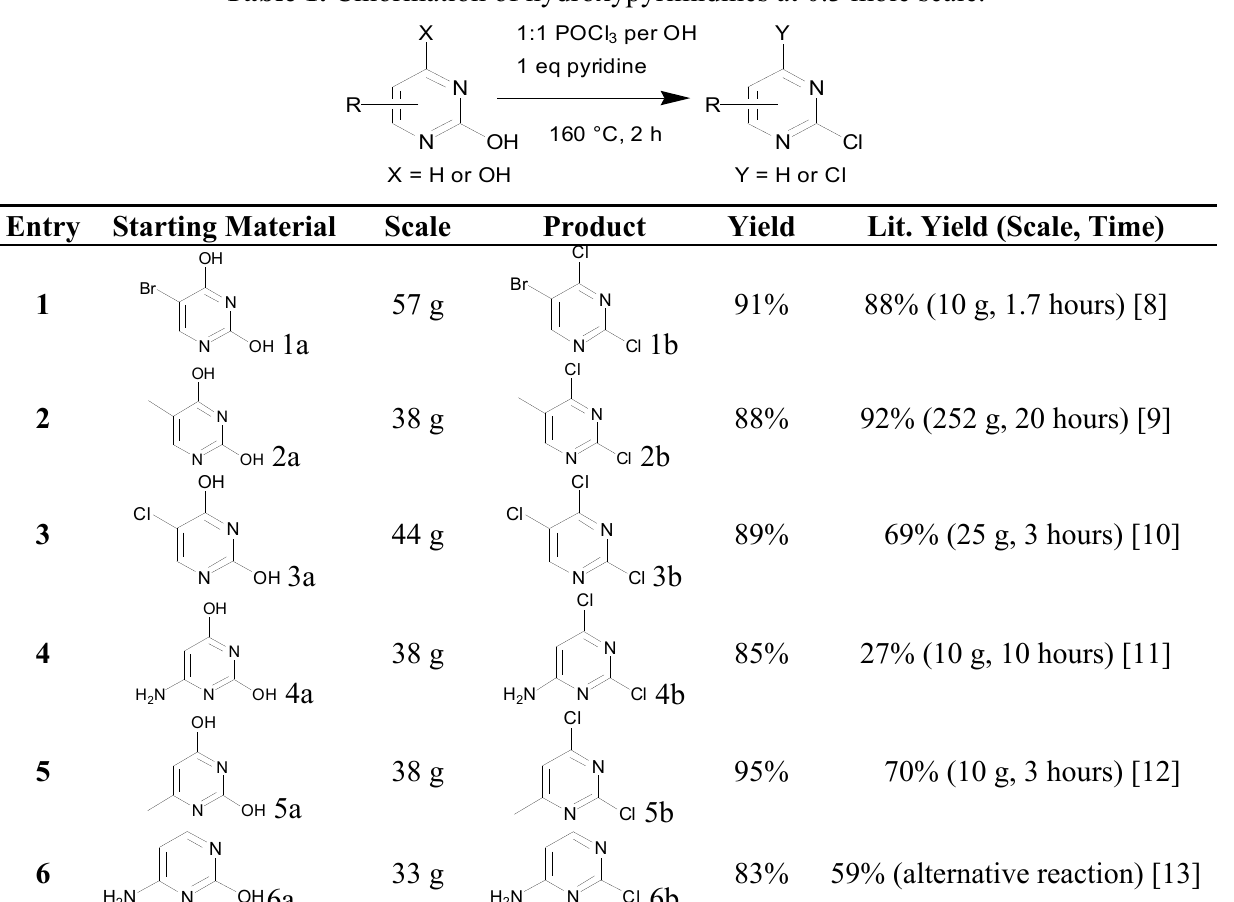
Table 1. Chlorination of hydroxypyrimidines at 0.3 mole